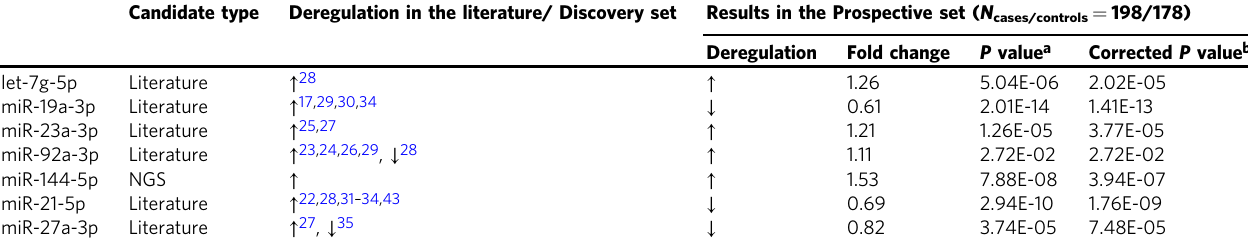
↑ represents signi fi cant upregulation. ↓ represents signi fi cant downregulation. a Values were generated from two-sided Mann – Whitney test. b Multiple testing correction by the method of Bonferroni – Holm 64